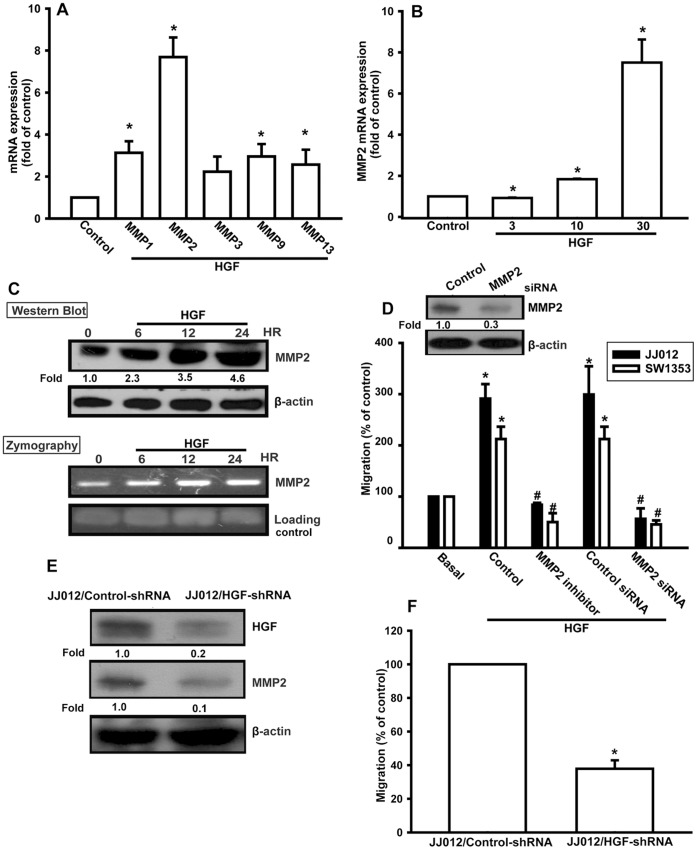
HGF-directed migration activity of human chondrosarcoma cells involves up-regulation of MMP-2.(A) JJ012 cells were incubated with HGF (30 ng/mL) for 24 h, the mRNA levels of MMP-1, −2, −3, −9, and −13 were determined using qPCR. (B) JJ012 cells were incubated with HGF for 24 h, and the mRNA level of MMP-2 then determined using qPCR. (C) JJ012 cells were incubated with HGF for the indicated time intervals. The cultured medium and cell lysates were then collected. The protein level of MMP-2 in cell lysates and the enzyme activity of MMP-2 in supernatants were examined by Western blotting and zymography. (D) JJ012 cells were treated with MMP-2 inhibitor for 30 min or were transfected with MMP-2 siRNA for 24 h, followed by stimulation with HGF; in vitro migration was then measured after 24 h. (E) Protein levels of HGF and MMP-2 in JJ012/control-shRNA and JJ012/HGF-shRNA cells was examined by western blotting. (F) In vitro migration activity of JJ012/control-shRNA and JJ012/HGF-shRNA cells was measured using a Transwell assay. Results are expressed as mean ± S.E. *p<0.05 compared with control; #p<0.05 compared with HGF-treated group.